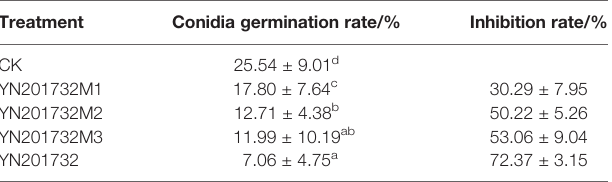
TABLE 3 | Inhibitory effect of Bacillus amyloliquefaciens YN201732 and the mutants fermentation fi ltrate on the conidia germination of Erysiphe cichoracearum . Treatment Conidia germination rate/%